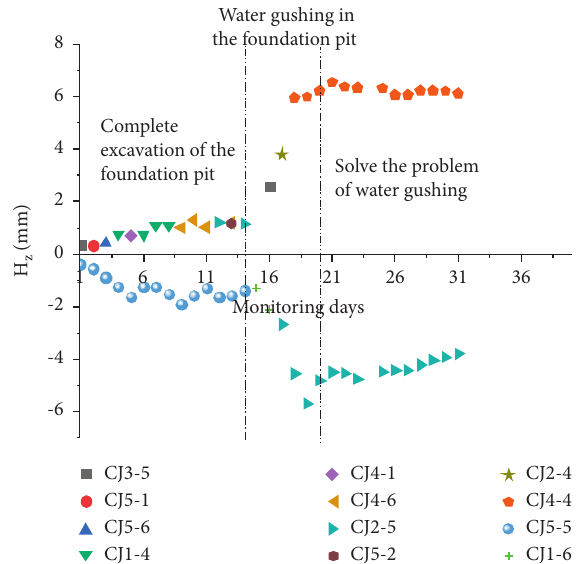
Figure 10: Changes in measurement points of the largest uplift and subsidence on the surface.